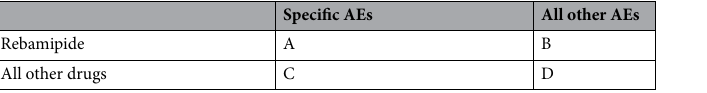
Table 4. 2 × 2 table for disproportionality analysis of rebamipide. (A) Rebamipide–specific AE pairs. (B) Rebamipide–all other AE pairs. (C) Other drug–specific AE pairs. (D) Other drug–all other AE pairs.